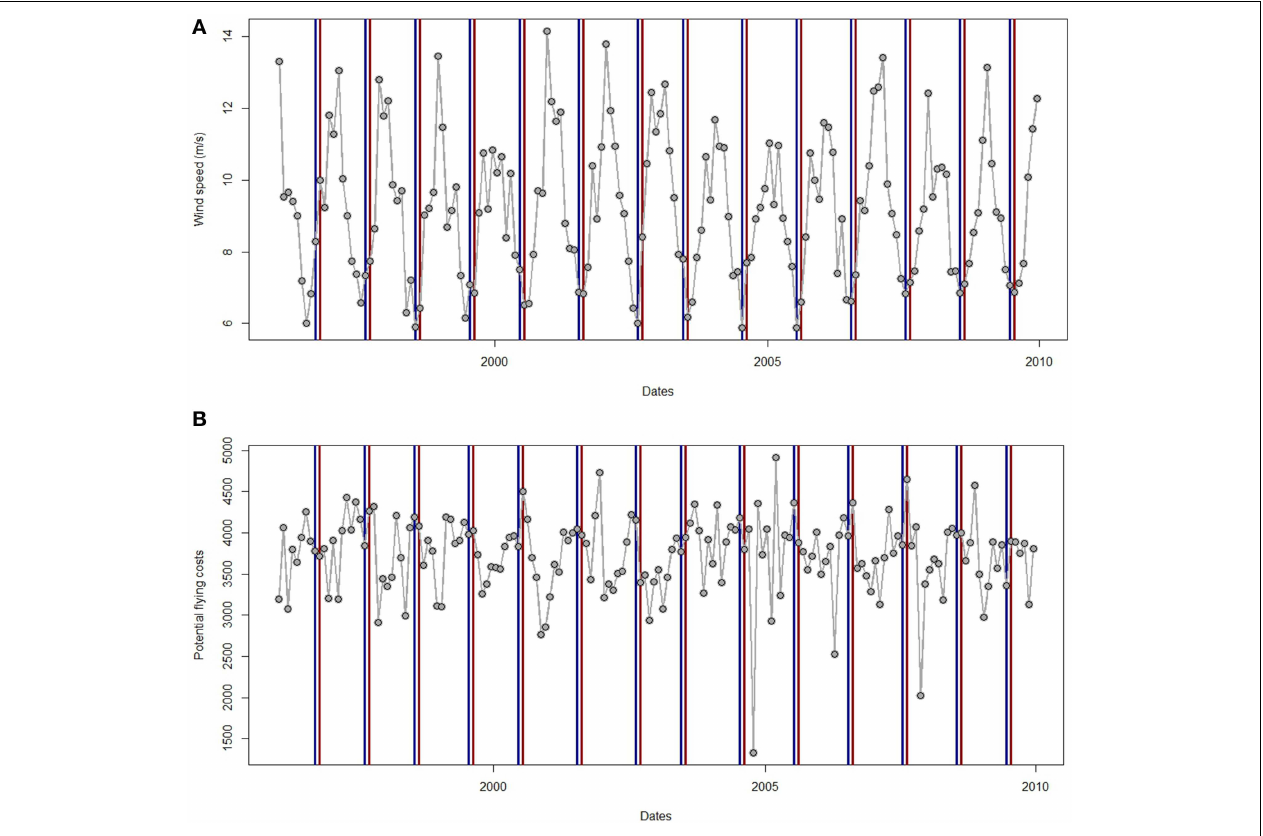
FIGURE 7 | (A) Time series of monthly wind speed and (B) potential flying cost (FC) from January 1996 to December 2009. Blue and red lines represent the month preceding the staging period and the month arriving to the Bay of Biscay for sooty shearwaters since time series are the same for great